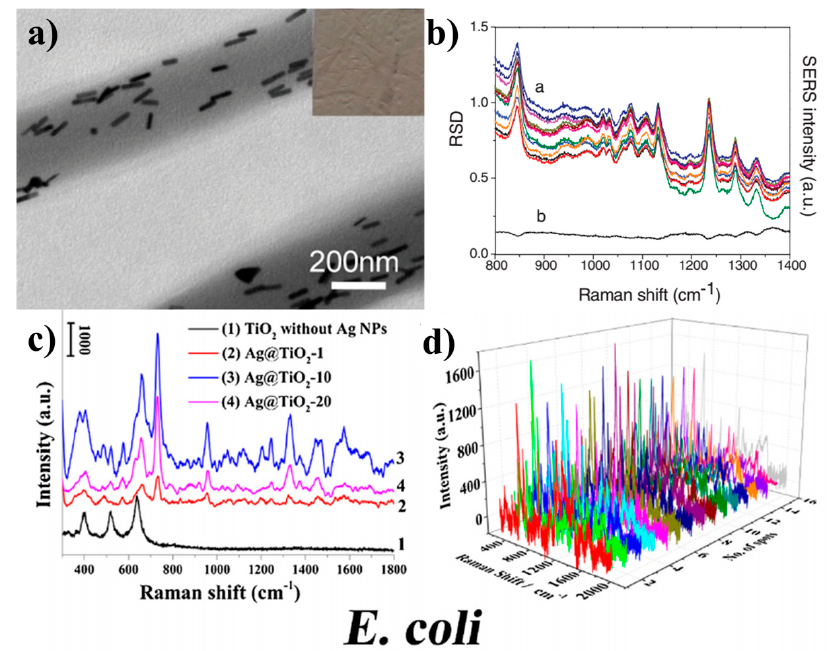
Figure 9. Electrospun NP interfaces for surface-enhanced Raman scattering (SERS) sensing: ( a ) TEM image of AuNRs assembled within the PVA nanofibers; ( b ) relative standard deviation (RSD)-SERS graph (1) SERS spectra of 10 –4 M 3,3 ′ -diethylthiatricarbocyanine iodide (DTTCI) collected from 12 randomly selected places on the optimized substrate and (2) the corresponding RSD value curve [123],